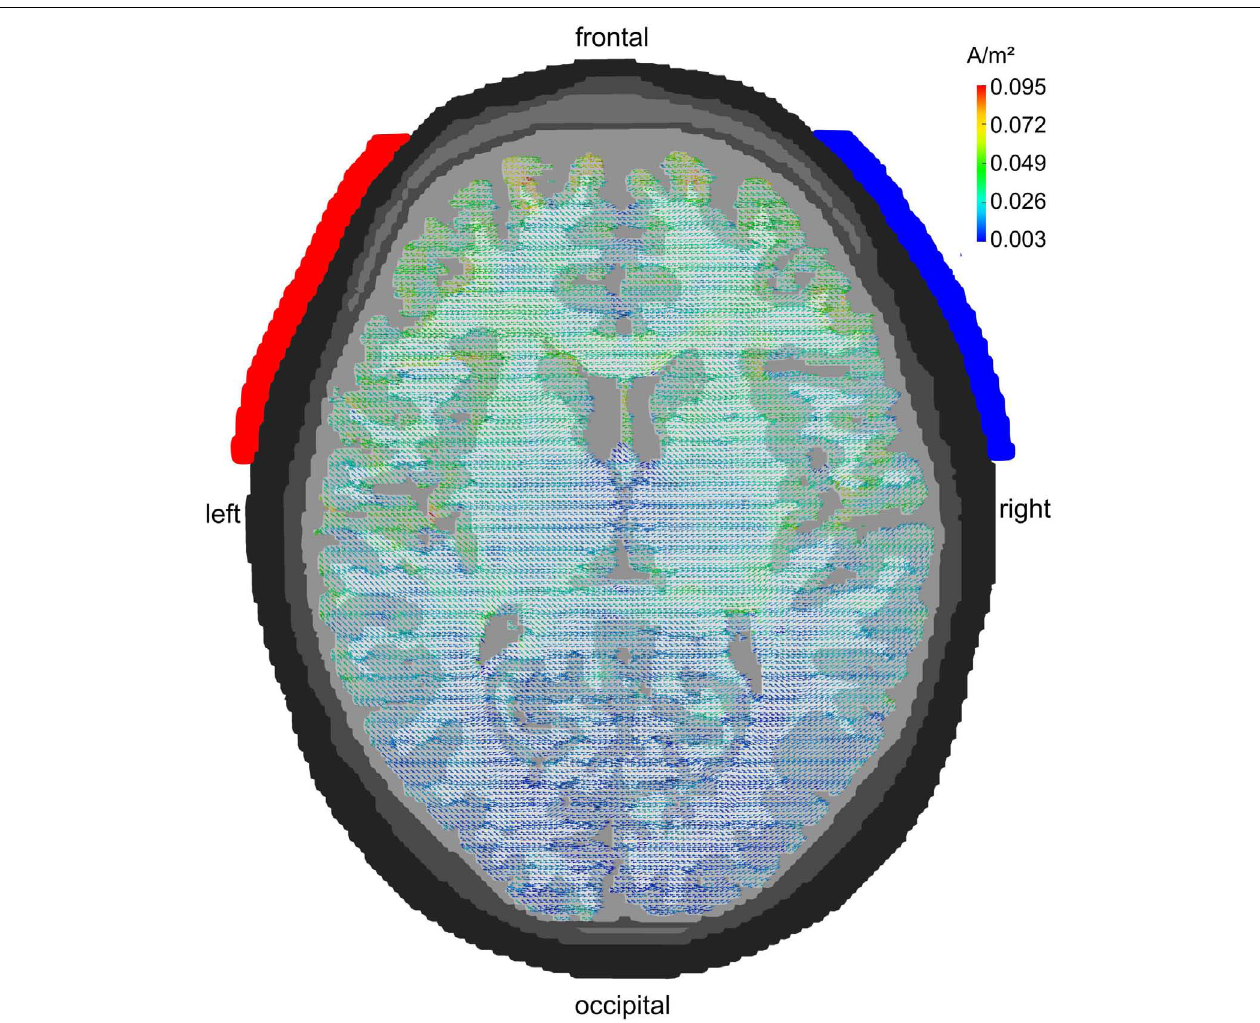
clearly localized to the frontal cortex.Temporal and parietal lobes show only weak current densities and the occipital lobe receives hardly any